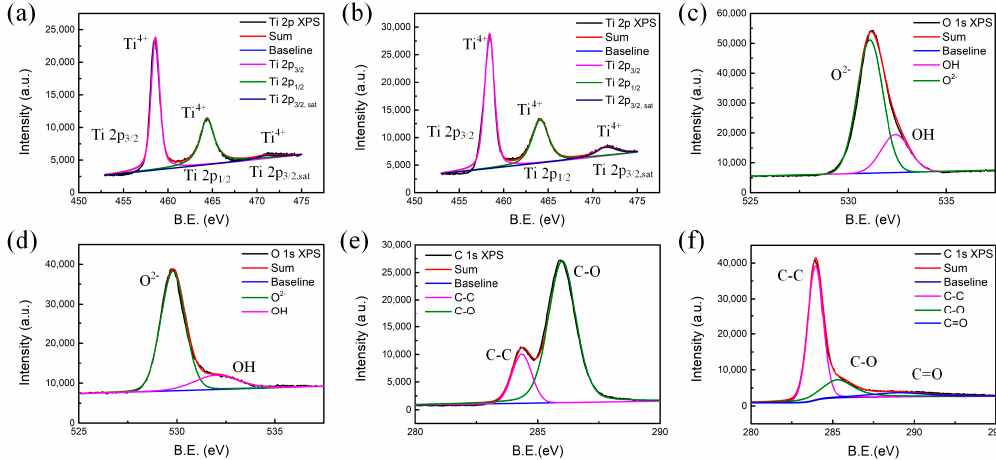
Figure 3. XPS spectra of ( a , b ) Ti 2p, ( c , d ) O 1s, and ( e , f ) C 1s of a-T2 and